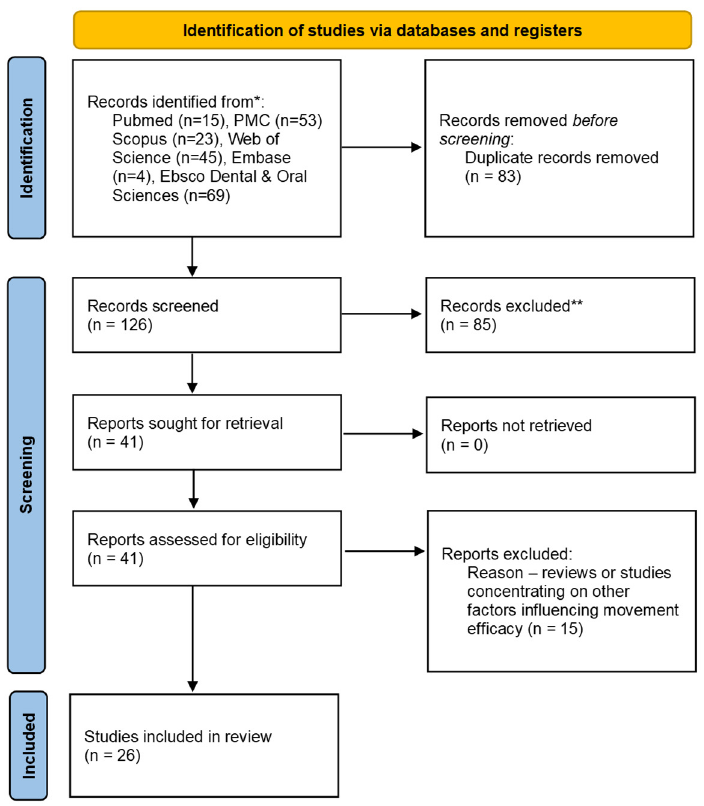
Figure 1. Prisma 2020 Flow Chart. *—detailed search strings presented in Chapter 2.1. **—studies not related to the review topic at all.